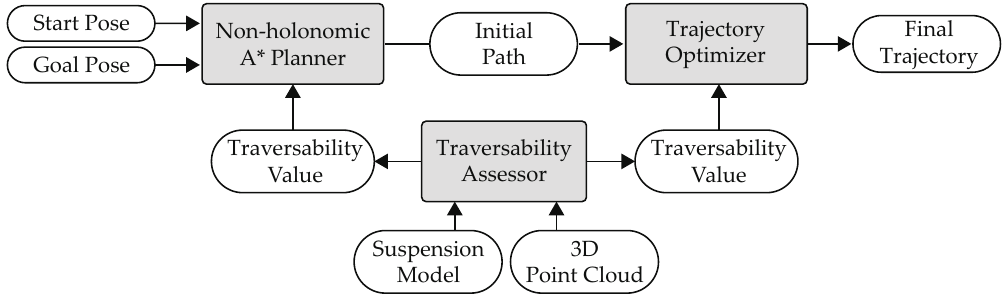
Figure 1. The architecture of the proposed traversability assessor and trajectory planner.